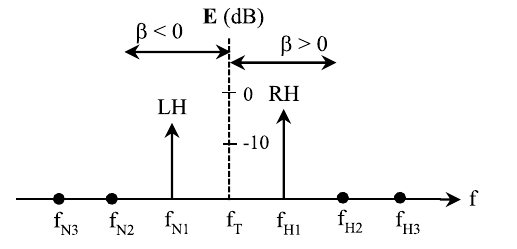
Fig. 7. Broadside radiation E Brd j n ¼ E for round model-C.